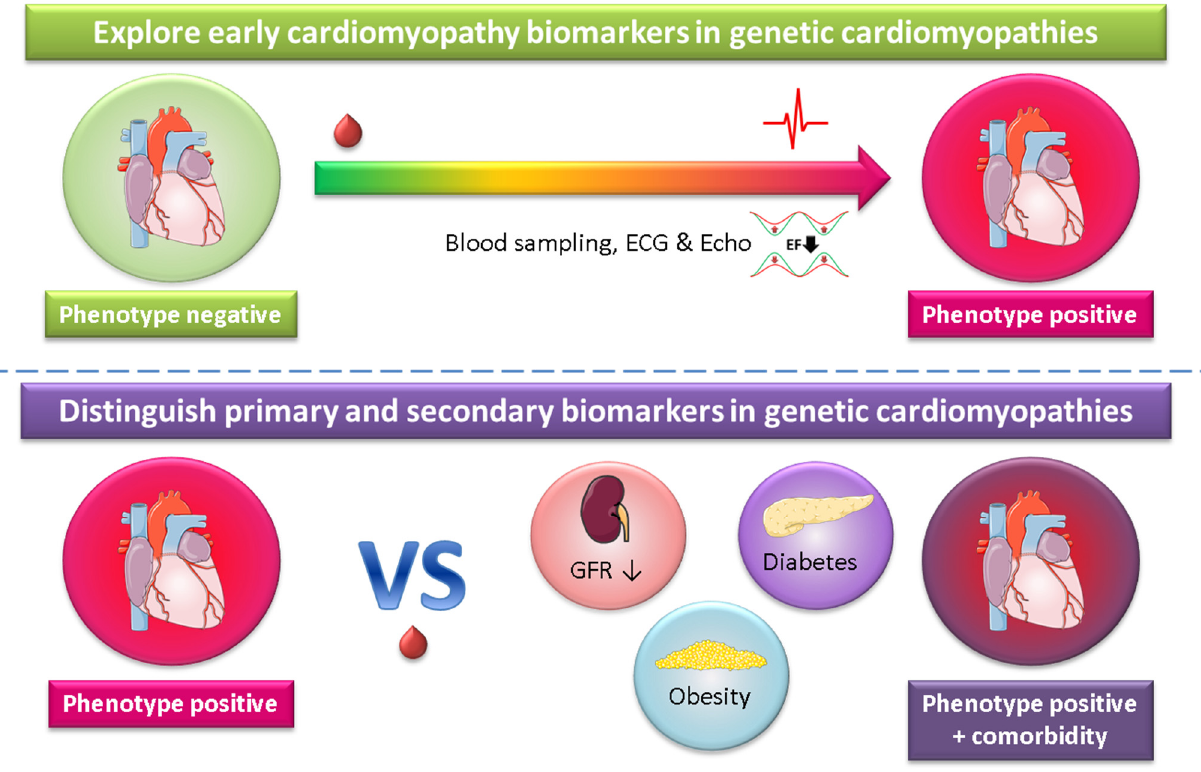
Figure 5. Genetic cardiomyopathy as a cardiac disease-specific model to explore biomarkers. ECG = electrocardiography, echo = echocardiography, EF = ejection fraction, GFR = glomerular filtration rate (a measure of kidney function). Components of the figure are derived from Servier Medical Art (https://smart.servier.com/, accessed on 14 March 2021), licensed under